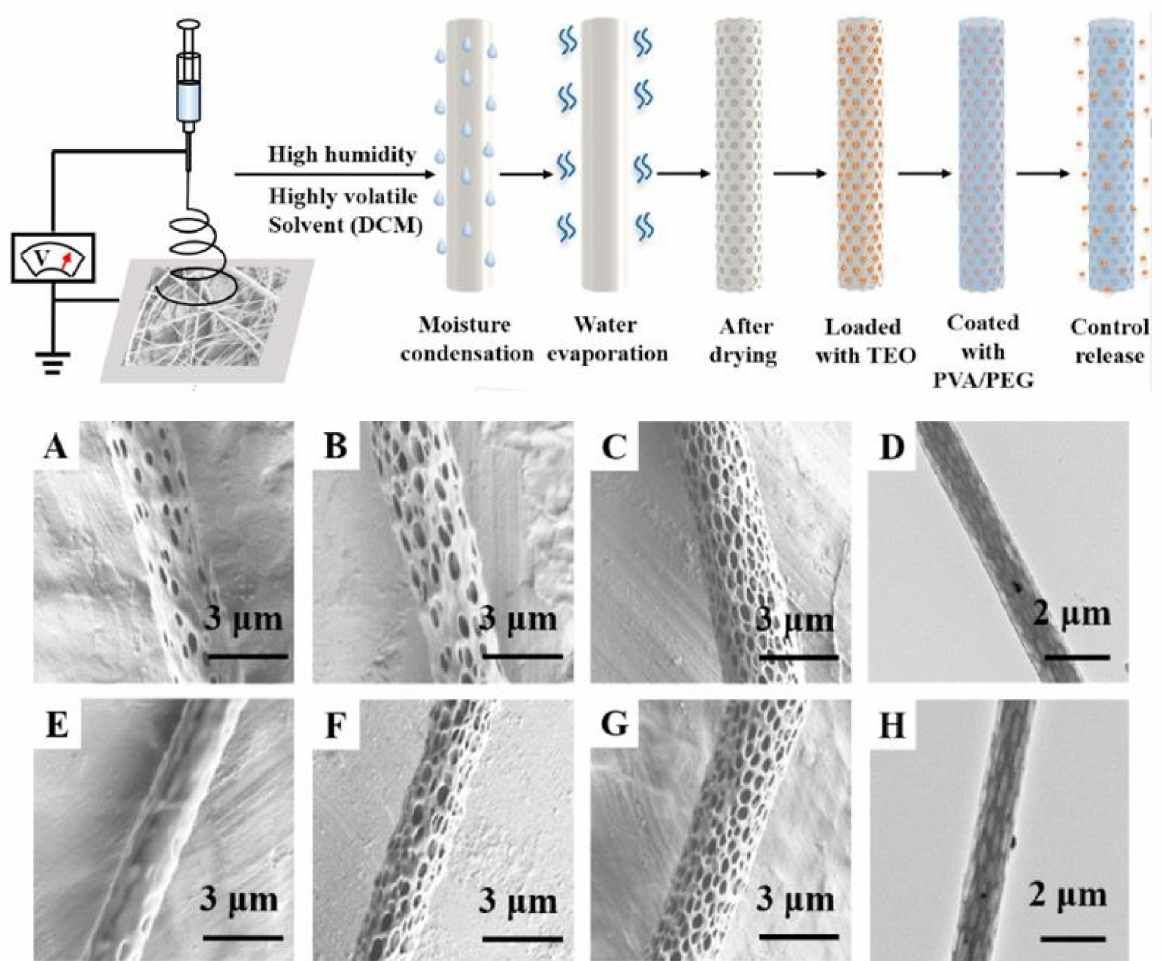
Figure 4. Pictorial visualization of the processes involved in pore formation of electrospun fibers and the SEM images of the obtained fibers showing the effect of dichloroethane/ethanol solvent ratio (90/10, 95/5, 100/0–( A – C )) and of ambient humidity (20%, 50%, 80%-( E – G )); TEM images of fibers ( D , H ). Adapted from [137]; copyright 2021,